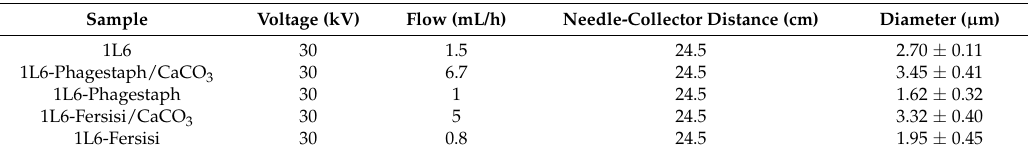
Figure 9. SEM micrographs showing electrospun 1L6 scaffolds loaded with: ( a ) Phagestaph/CaCO 3 , ( b ) Fersis/CaCO 3 . Diameter distributions are shown on the right of the corresponding micrograph. Table 2. Electrospinning parameters and diameter sizes for the unloaded and the differently loaded 1L6